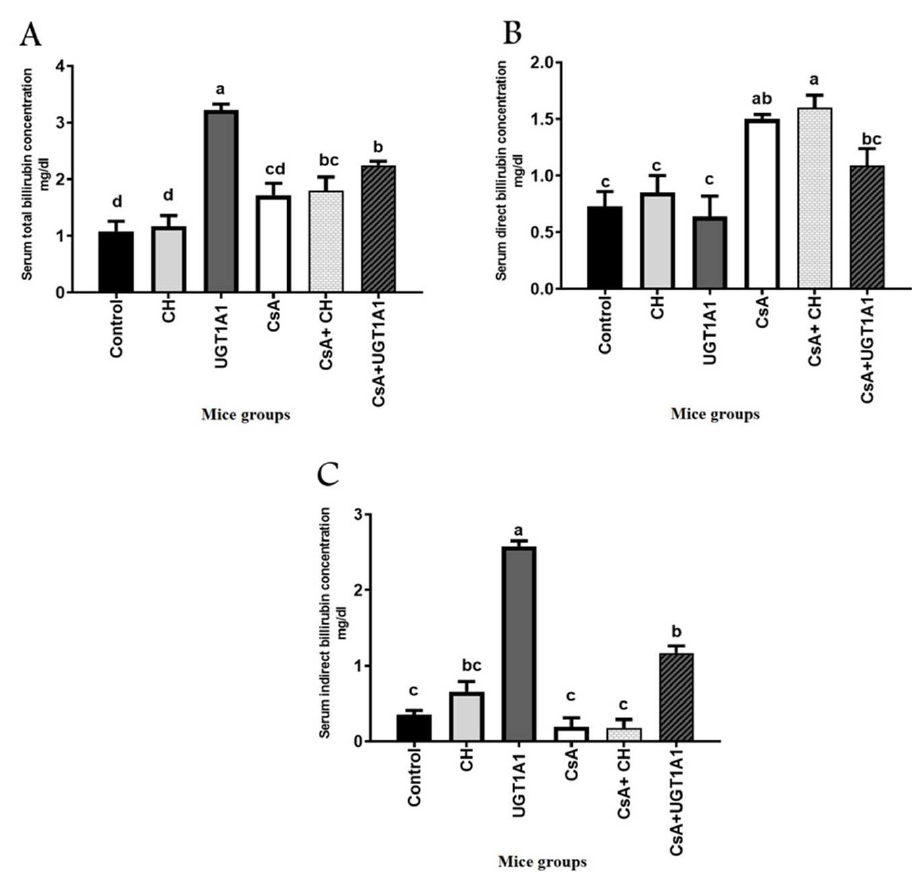
Figure 1. UGT1A1 antisense oligonucleotide mediates physiological unconjugated hyperbilirubinemia in CsA-treated mice: ( A ) total bilirubin (TB); ( B ) direct bilirubin (conjugated bilirubin; CB); and ( C ) indirect bilirubin (unconjugated bilirubin; UCB). Values are expressed as mean ± SEM ( n = 8). Means of different letters are statistically different ( p < 0.05) (ANOVA; Duncan’s post hoc analy- sis) .